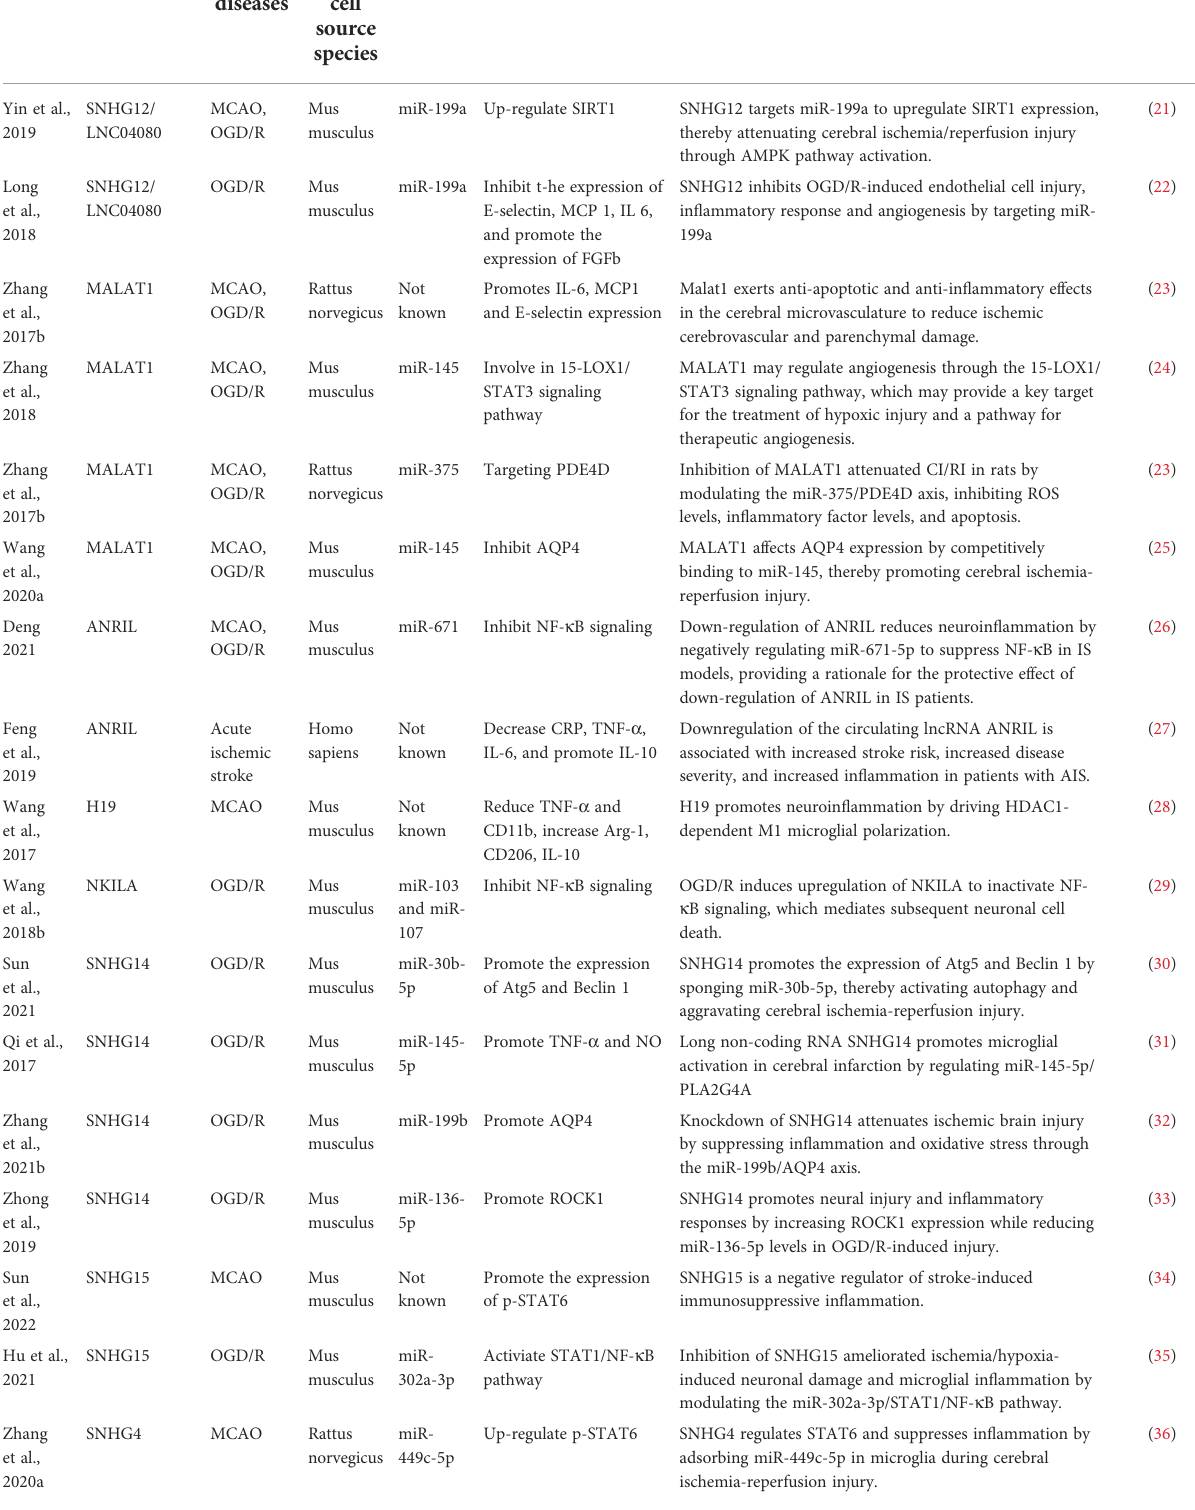
TABLE 1 Summary of the mechanisms of lncRNAs in cerebral